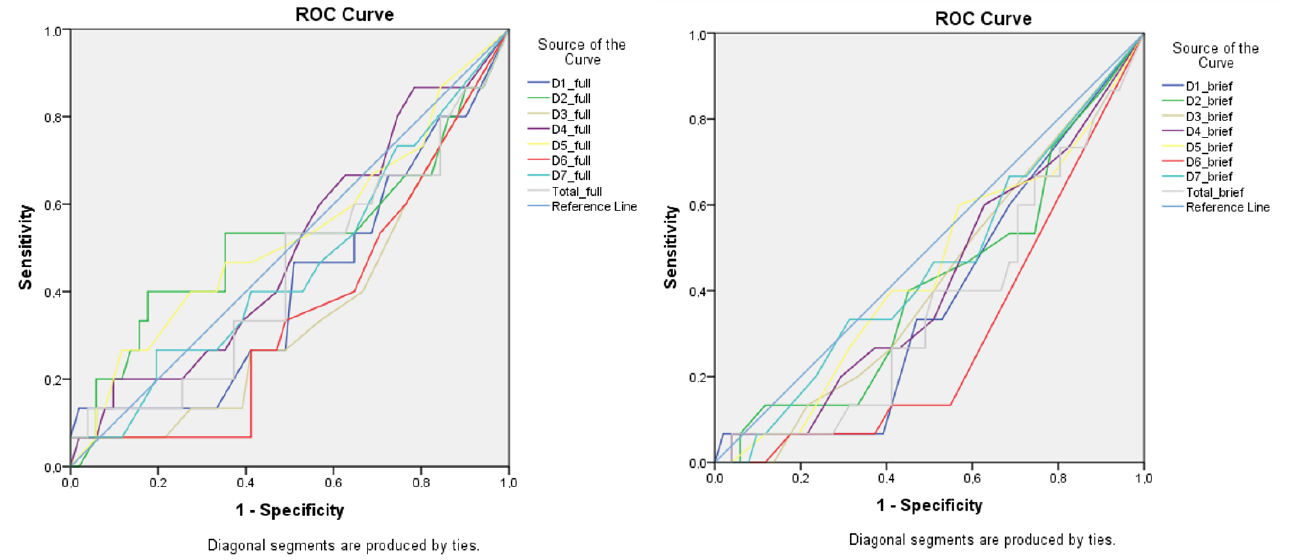
Figure 2. ROC curves of the CaffEQ-BR full (left) and brief (right) versions. The colored lines are the recorded scores of the 7 CaffEQ-BR factors for discrimination of the ADORA2A genotypes considering TT group as the reference level (0.5 = reference diagonal line, no discriminatory for sensitivity or specificity). Factors: D1: withdrawal/dependence; D2: energy/work enhancement; D3: appetite suppression; D4: social/mood enhancement; D5: physical performance enhancement; D6: anxiety/negative physical effects; D7: sleep disturbance.